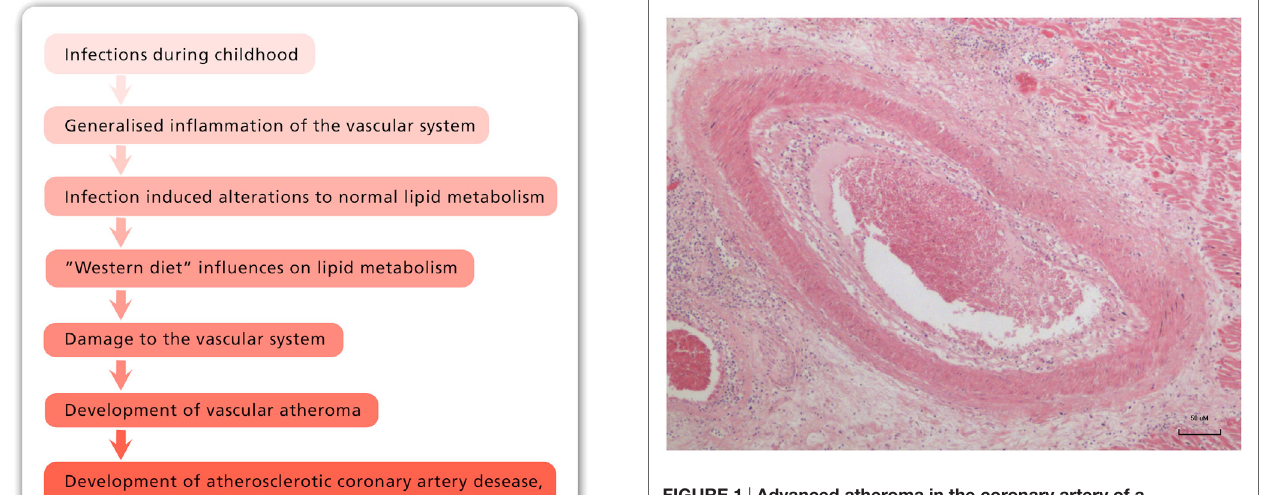
FiGURe 1 | Advanced atheroma in the coronary artery of a 17–year-old girl (13)